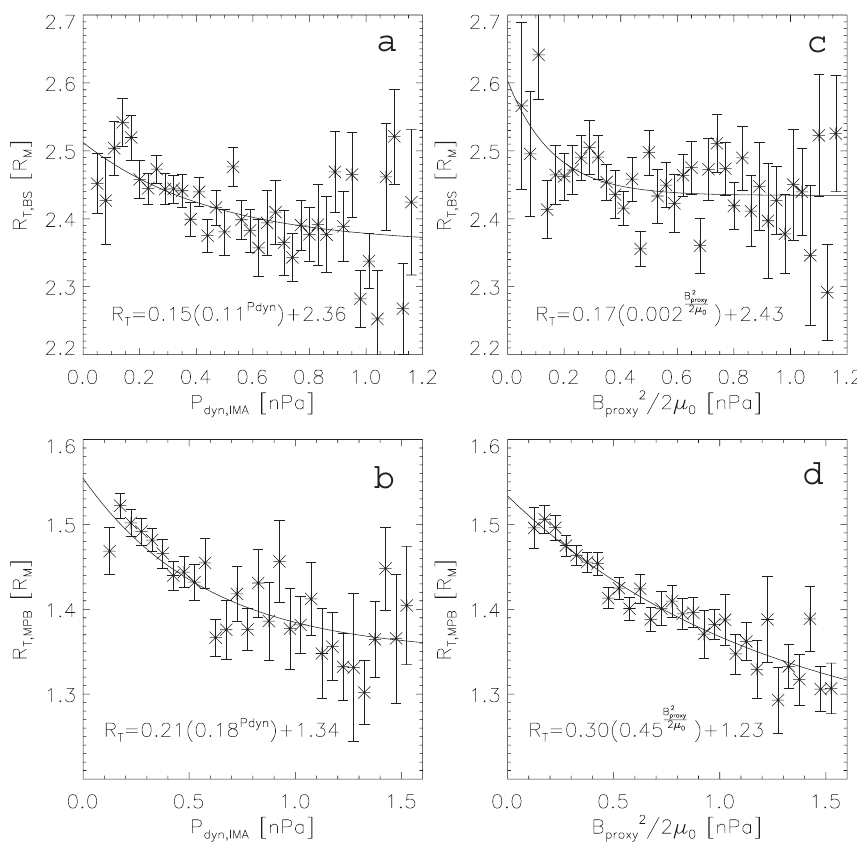
Fig. 6. The extrapolated terminator distance of all (a) BS and (b) MPB crossings observed by MEX from February 2004 until November 2006 plotted as a function of solar wind dynamic pressure measured outside of the BS by MEX/IMA and the extrapolated terminator distance of all (c) BS and (d) MPB crossings as a function of the MGS pressure proxy linearly interpolated to the time of the crossings. The curve in each panel is a least square exponential fit to the data. The error bars show standard error on the